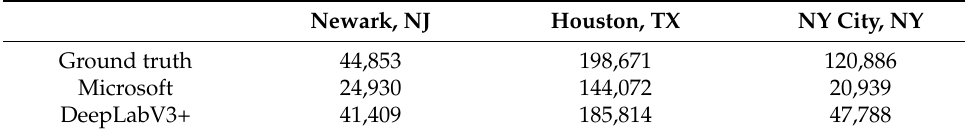
Table 3. Number of detected footprints. Newark, NJ Houston, TX NY City, NY Ground truth 44,853